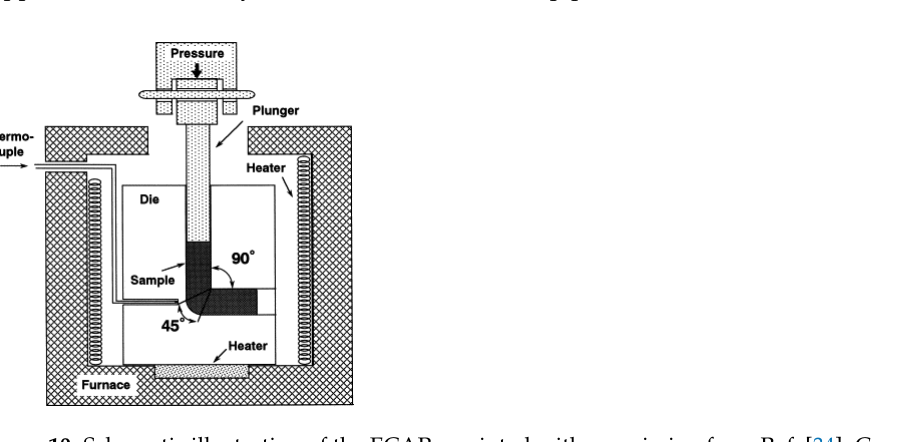
Figure 10. Schematic illustration of the ECAP reprinted with permission from Ref. [34]. Copyright 2022, ELSEVIER.